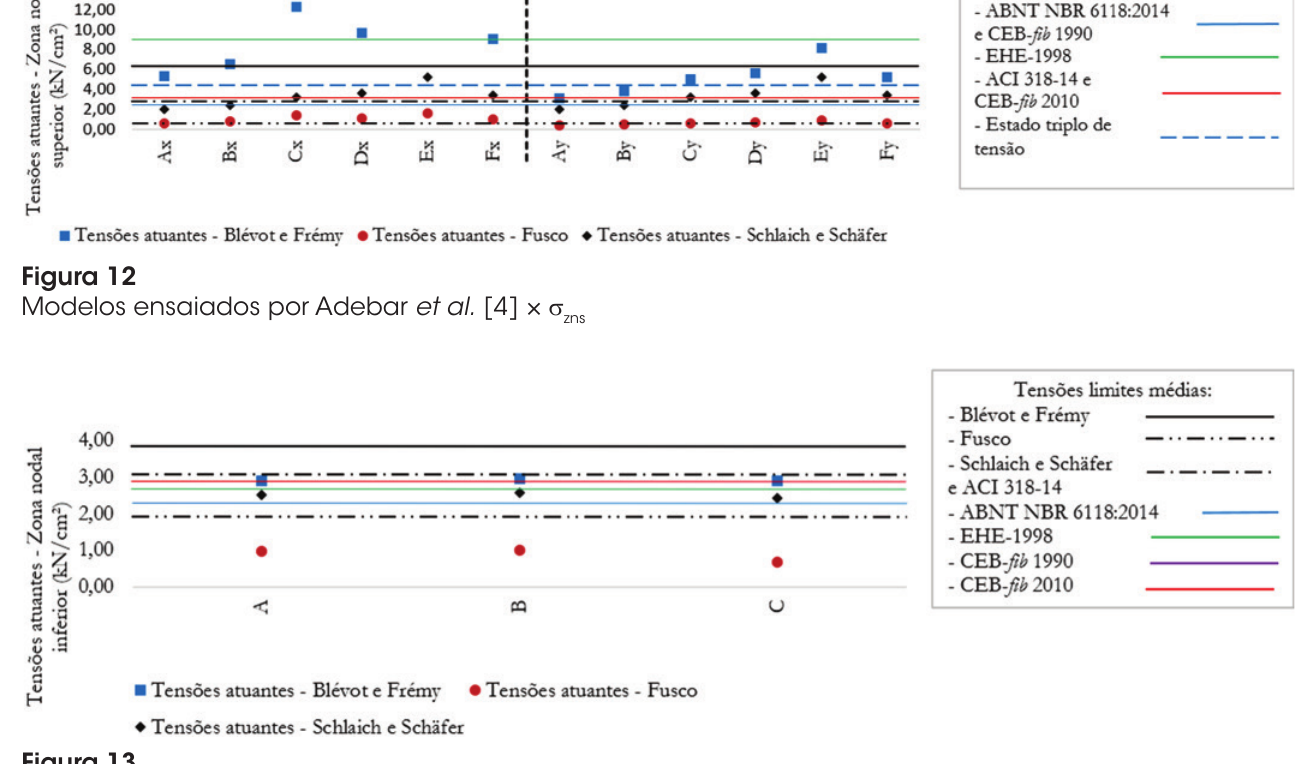
Modelos ensaiados por Chan e Poh [7] × σ